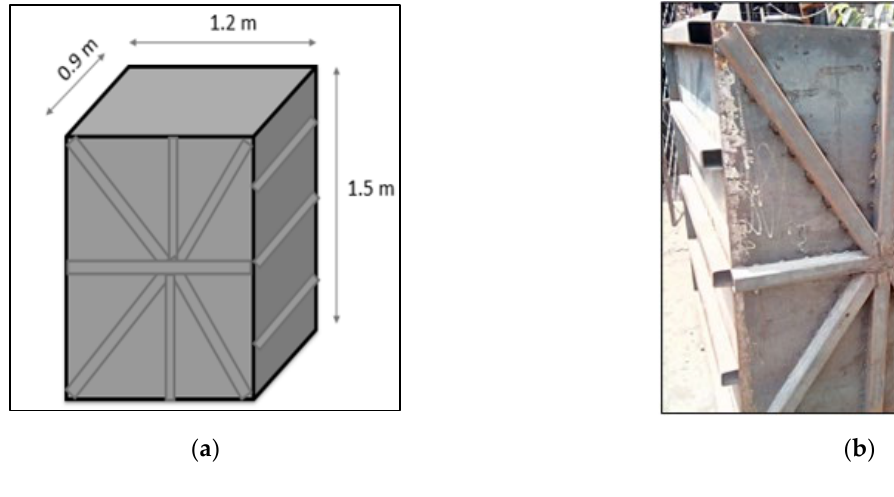
Figure 2. ( a ) Soil box; ( b ) stiffeners on each side.